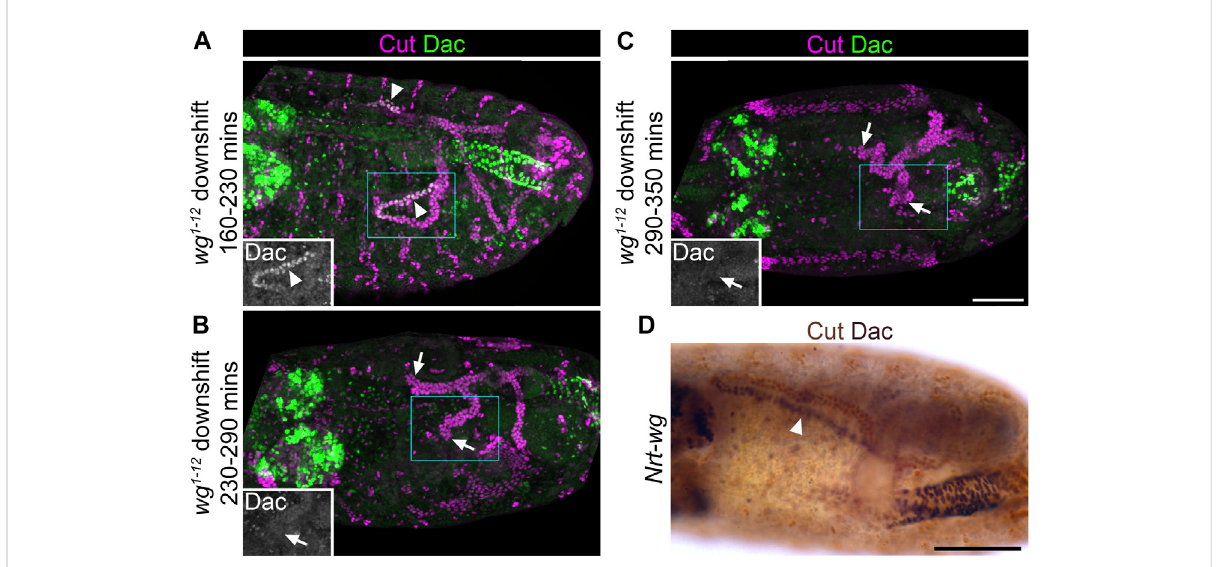
FIGURE 7 Wingless is required during early tubule formation for speci fi cation of distal tubule identity. (A – C) ~Stage 15 – 16 embryos stained to show MpT nuclei (anti-Cut) and the nuclei of cells from the distal MpT segment (anti-Dac, arrowheads). Arrows show distal MpT regions not expressing Dac. Embryos are homozygous for a temperature sensitive allele of wg ( wg 1-12 ). (A) Raised at the restrictive temperature until 160 – 230 min, when shifted to the permissive temperature. (B) Raised at the restrictive temperature until 230 – 290 min when shifted to the permissive temperature. (C) Raised at therestrictivetemperature until 290 – 350 min whenshifted to thepermissive temperature. Single channel imagesequate to region in blue box of merged image. Scale bar = 50 μ m. (D) ~Stage 15 – 16 embryo stained to show MpT nuclei (anti-Cut, brown) and the nuclei of cells from the distal MpT segment (anti-Dac, black, arrowheads). Embryo is a homozygote in which endogenous wg has been replaced with Nrt-wg . Scale bar = 50 μ